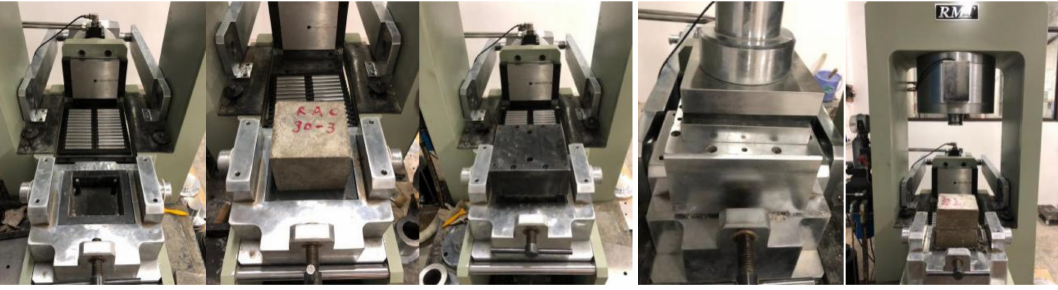
Figure 2. Direct shearing test: shearing device.